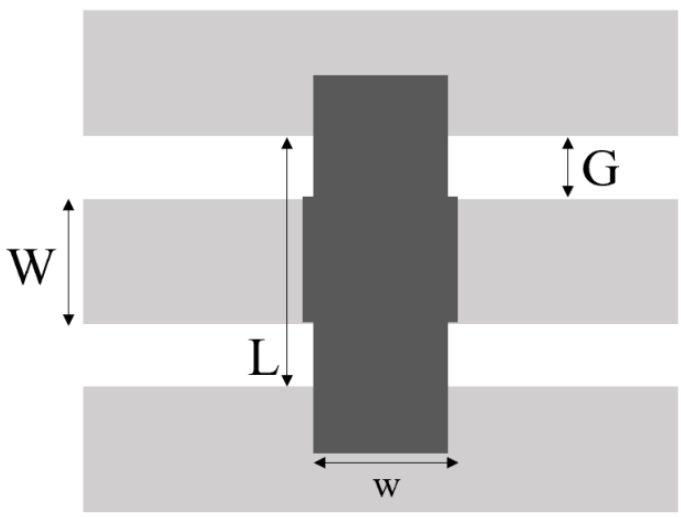
Figure 2. 3D view of the RF MEMS capacitive shunt switch.